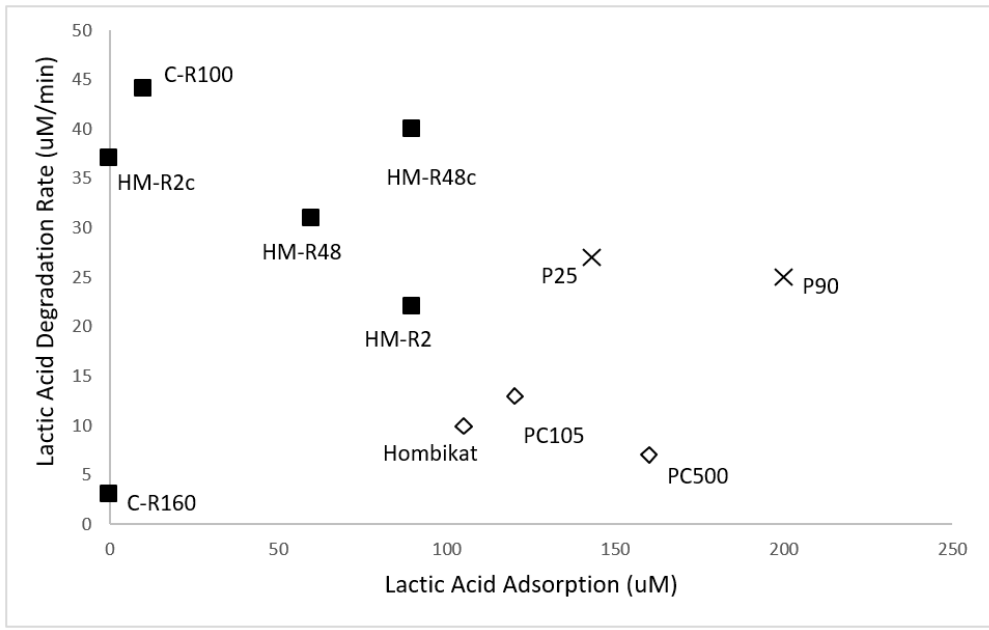
Figure 4. LA degradation rate in the presence of rutile TiO 2 (filled squares), anatase TiO 2 (diamonds), and mixed anatase/rutile TiO 2 (cross) as a function of LA adsorption.